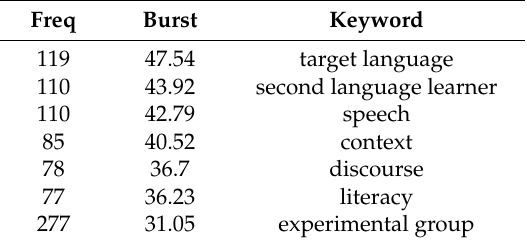
Table 16. The top 20 burst